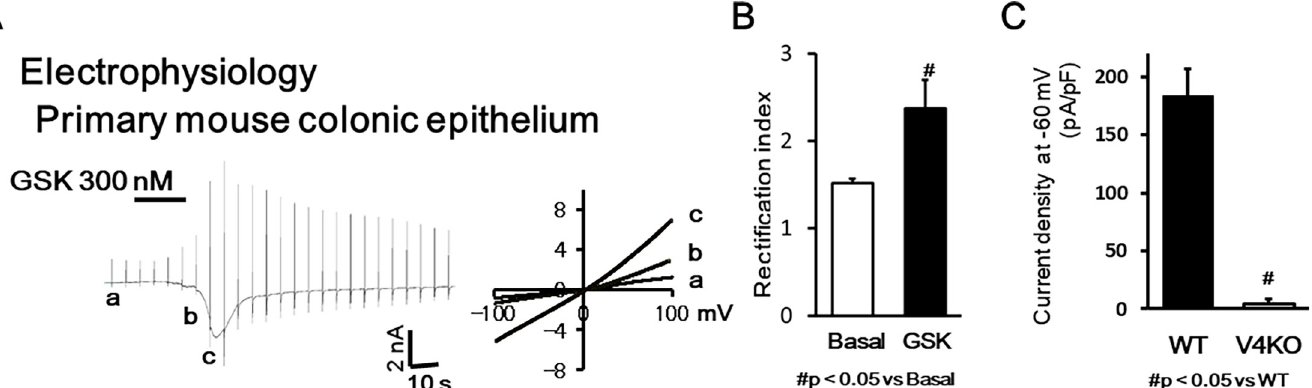
Fig 4. TRPV4-mediated current responses in mouse primary colonic epithelial cells. (A) TRPV4-mediated current responses in mouse primary colonic epithelial cells (mean ± SEM). GSK101 (300 nM) evoked inward current responses in WT primary colonic epithelial cells. Currents in response to ramp-pulses at points a, b and c (left) are shown (middle), with a strong outwardly rectifying current-voltage relationship (reversal potential of 0.4 mV). (B) Summary data of rectification between basal condition (at “a” in Fig 4A) and GSK101-induced currents (at “b” in Fig 4A) in WT cells (n = 5; p < 0.05 vs. Basal). (C) Significantly larger inward current densities (pA/ pF) at -60 mV were obtained from WT cells (n = 5) than from TRPV4-KO cells (n = 5; # p < 0.05 vs. WT).